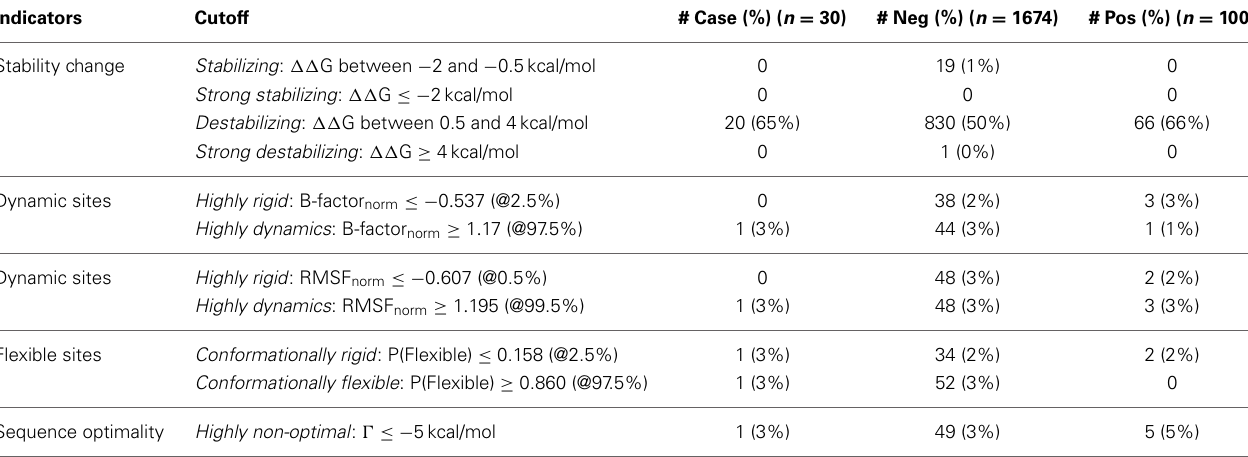
Sequence optimality